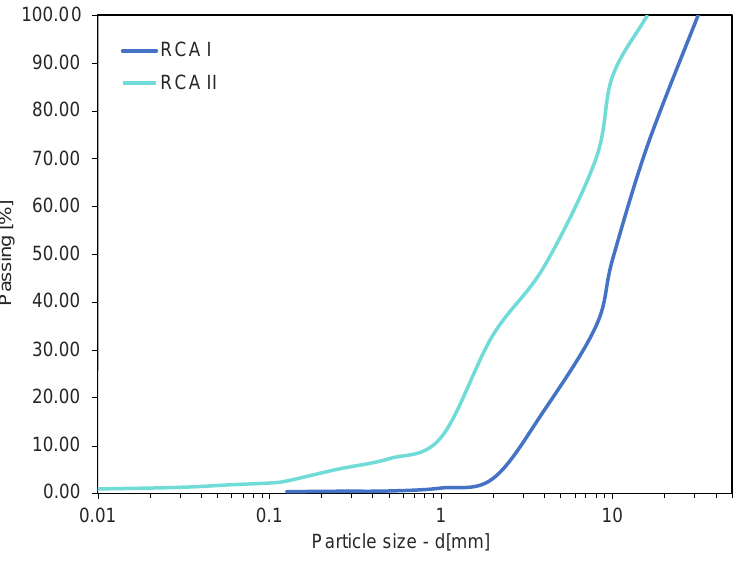
Figure 1. Grain size curve of tested materials.